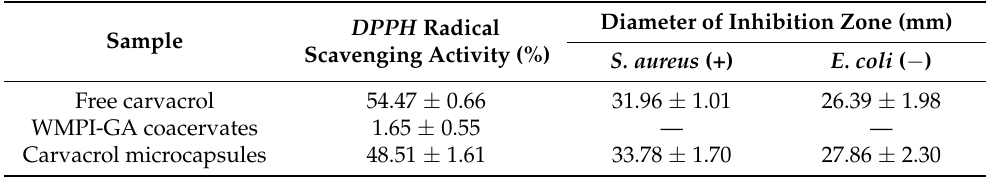
Table 1. Antioxidant and antibacterial capacity of the free carvacrol, WMPI-GA coacervates and carvacrol microcapsules. Diameter of Inhibition Zone (mm) DPPH Radical Sample Scavenging Activity (%) S. aureus (+) E. coli ( − ) Free carvacrol 54.47 ± 0.66 31.96 ± 1.01 26.39 ± 1.98 WMPI-GA coacervates 1.65 ± 0.55 — — Carvacrol microcapsules 48.51 ± 1.61 33.78 ± 1.70 27.86 ±